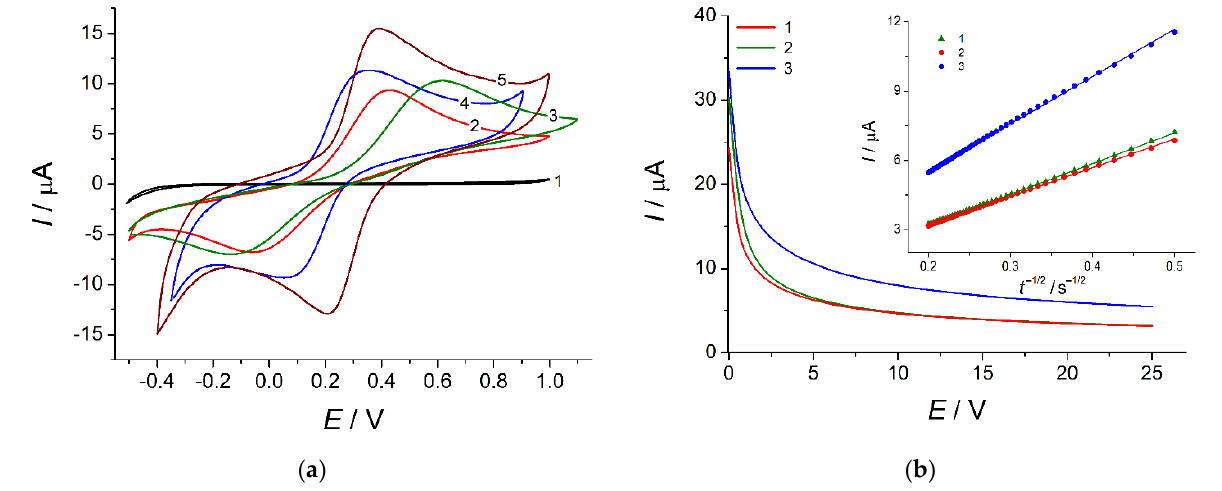
Figure 6. ( a ) CVs of 1.0 mM [Fe(CN) 6 ] 4 − on bare GCE (curve 2), polyBCP/GCE (curve 3), f-SWCNTs/GCE (curve 4) and polyBCP/f-SWCNTs/GCE (curve 5) in 0.1 M KCl (curve 1), υ = 100 mV s ‒ 1 . ( b ) Chronoam- perograms of 1.0 mM [Fe(CN) 6 ] 4 − on bare GCE (curve 1), polyBCP/GCE (curve 2) and f-SWCNTs/GCE (curve 3). Insert is the plot of I vs. t − 1/2 obtained from chronoamperometric